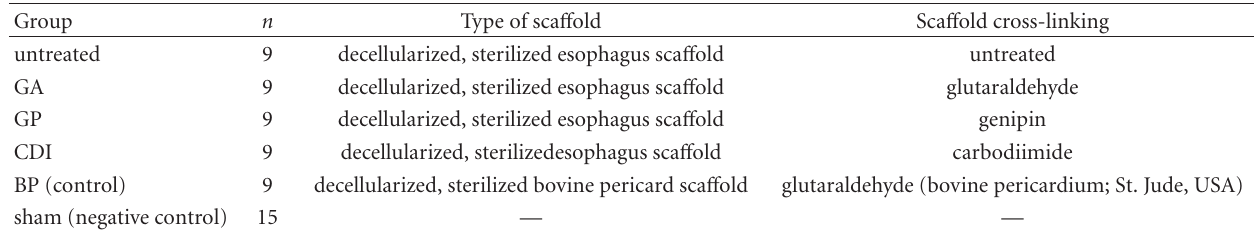
Table 1: Group composition with type and cross-linking of sca ff